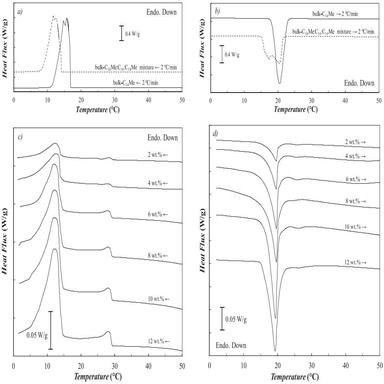
(a,c) Cooling and (b,d) heating DSC thermograms obtained at β = 2 ◦C/min for (a,b) bulk− C14Me and bulk− C18Me:C16:C14Me materials and (c,d) optimized C18Me:C16:C14Me− in− water nanoemulsions.